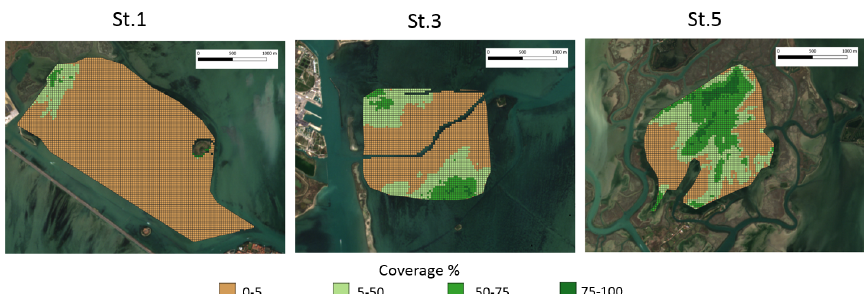
Figure 7. Macrophyte distribution derived from BOMBER and clustered in four categories of bottom coverage: 0 to 5% in the case of bare sediment; 5 to 50%, sparse vegetation; 50 to 75%, moderately dense macrophytes; and 75 to 100%, corresponding to dense macrophyte meadows.